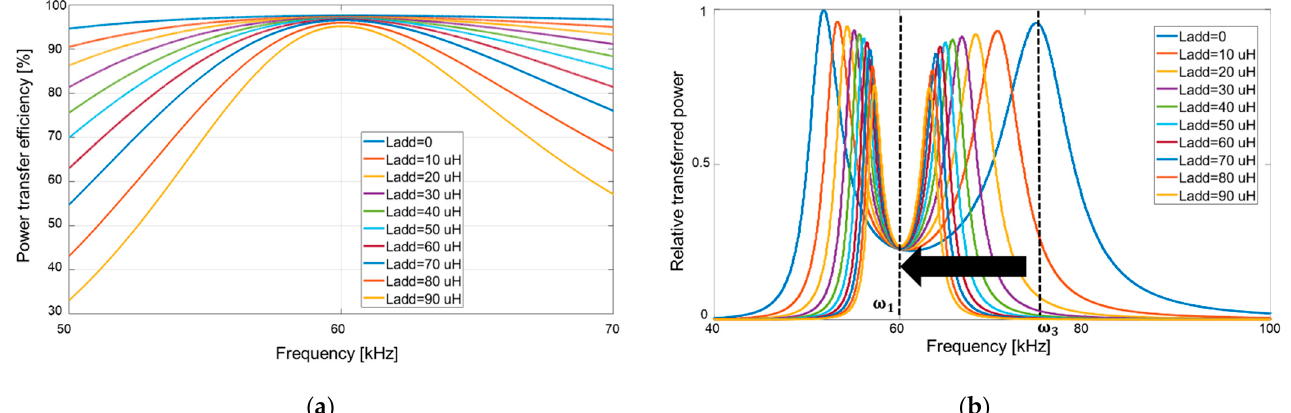
Figure 15. PTE and relative transferred power to load change according to the series inductance value (L add-tx , L add-rx ): ( a ) change in PTE according to frequency change; ( b ) change in relative transferred power according to frequency change.